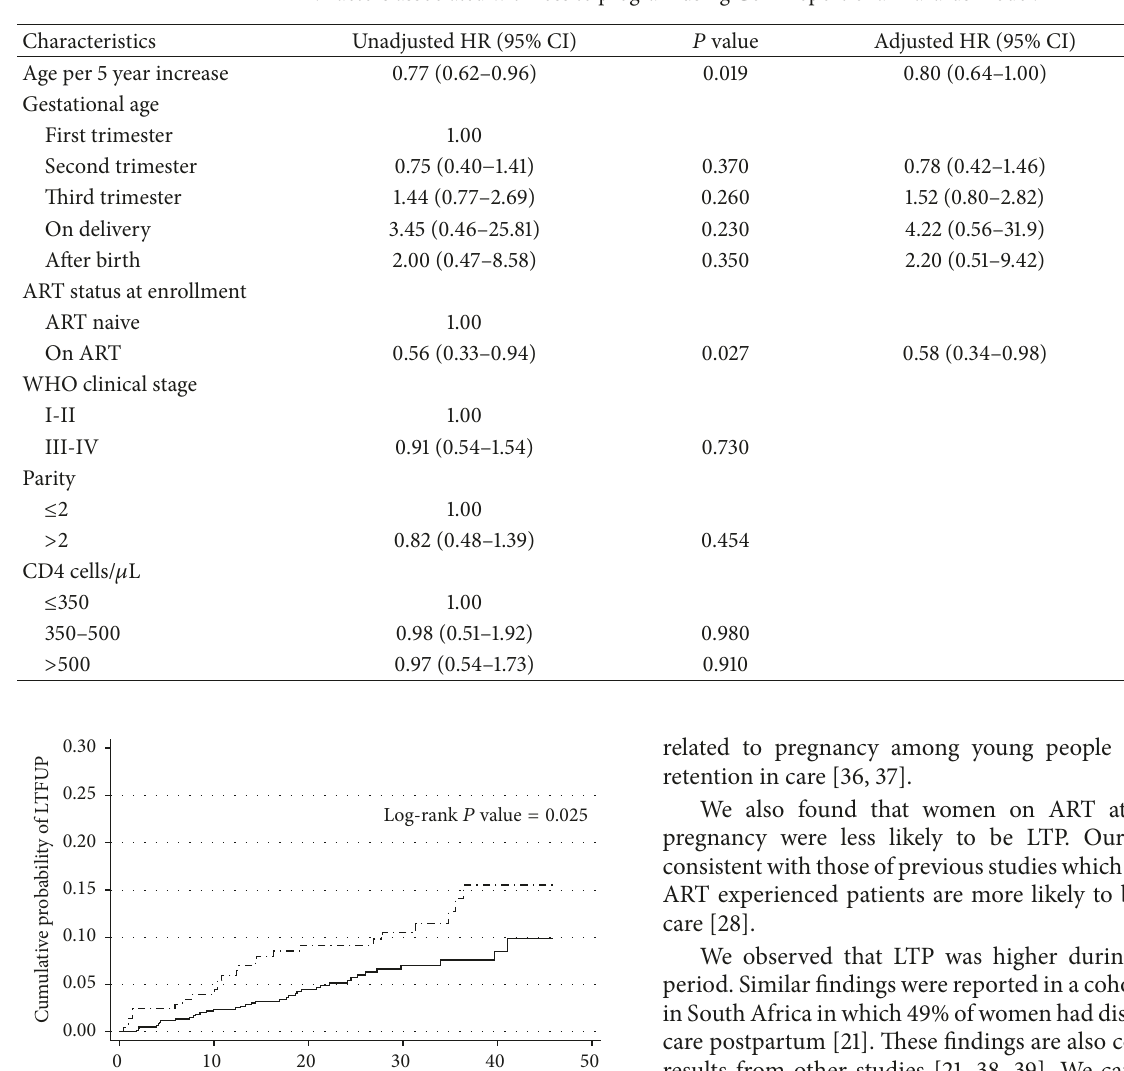
Table 2: Factors associated with loss to program using Cox Proportional Hazards model.